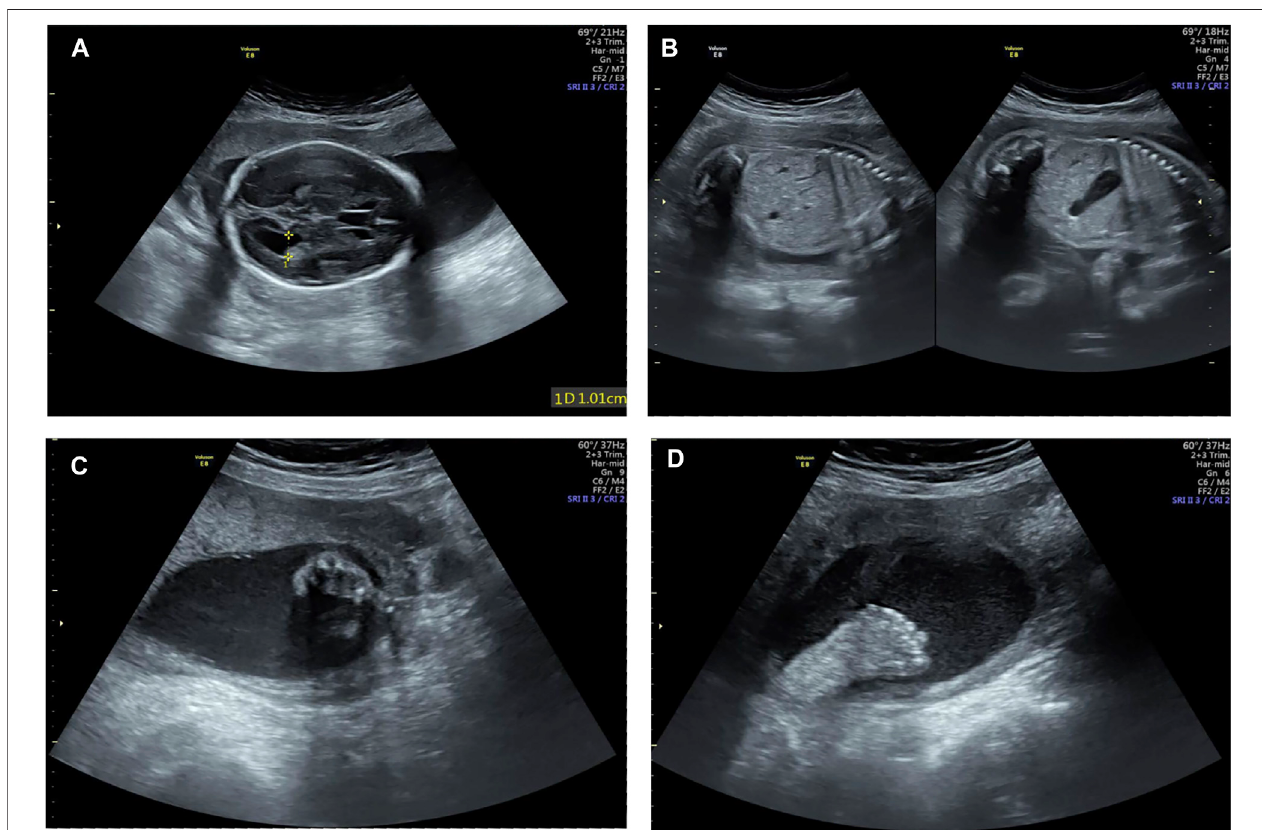
FIGURE 1 | Examination image of the fetus. Fetal ultrasound scan showed fetus malformation including lateral ventricle widening (A) , bilateral renal echo enhancement (B) , and polydactyly (C,D) .